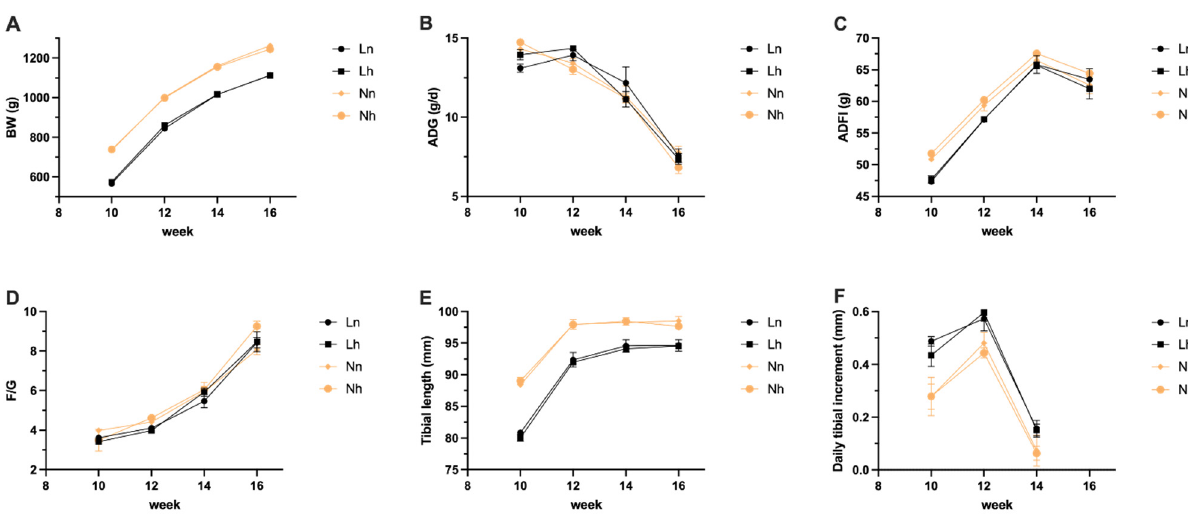
Figure 2. Effects of phosphorus restriction in brooding stage and subsequent recovery on growth performance of layers during 10–16 weeks of age. ( A ) BW ( B ) ADG ( C ) ADFI ( D ) F/G ( E ) Tibial length ( F ) Daily tibial increment. BW = body weight, ADG = average daily gain; ADFI = average daily feed intake; F/G = the ratio of feed to gain. Ln = group fed 0.13% nPP at 1–8 weeks and fed 0.39% nPP at 9–20 weeks; Lh = group fed 0.13% nPP at 1–8 weeks and fed 0.45% nPP at 9–20 weeks; Nn = group fed 0.45% nPP at 1–8 weeks and fed 0.39% nPP at 9–20 weeks; Nh = group fed 0.45% nPP at 1–8 weeks and fed 0.45% nPP at 9–20 weeks. Data are shown as mean ± SEM.